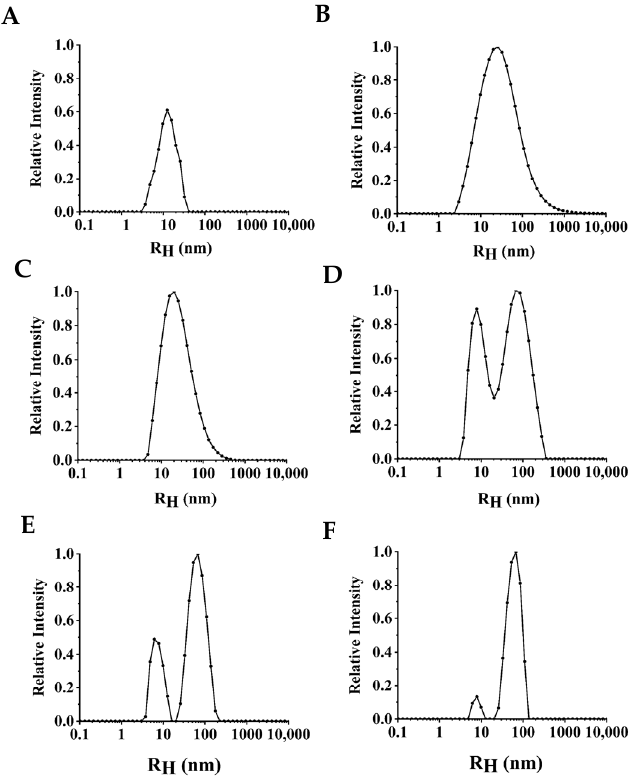
Figure 3. Effects of thermal treatment at different temperatures (untreated, 60, 70, 80, 90, and 100 °C) for 10 min on the particle size distribution of ferritin. Figures ( A – F ) are, respectively, control (untreated ferritin) and thermal treatment of 60, 70, 80, 90, and 100 °C.